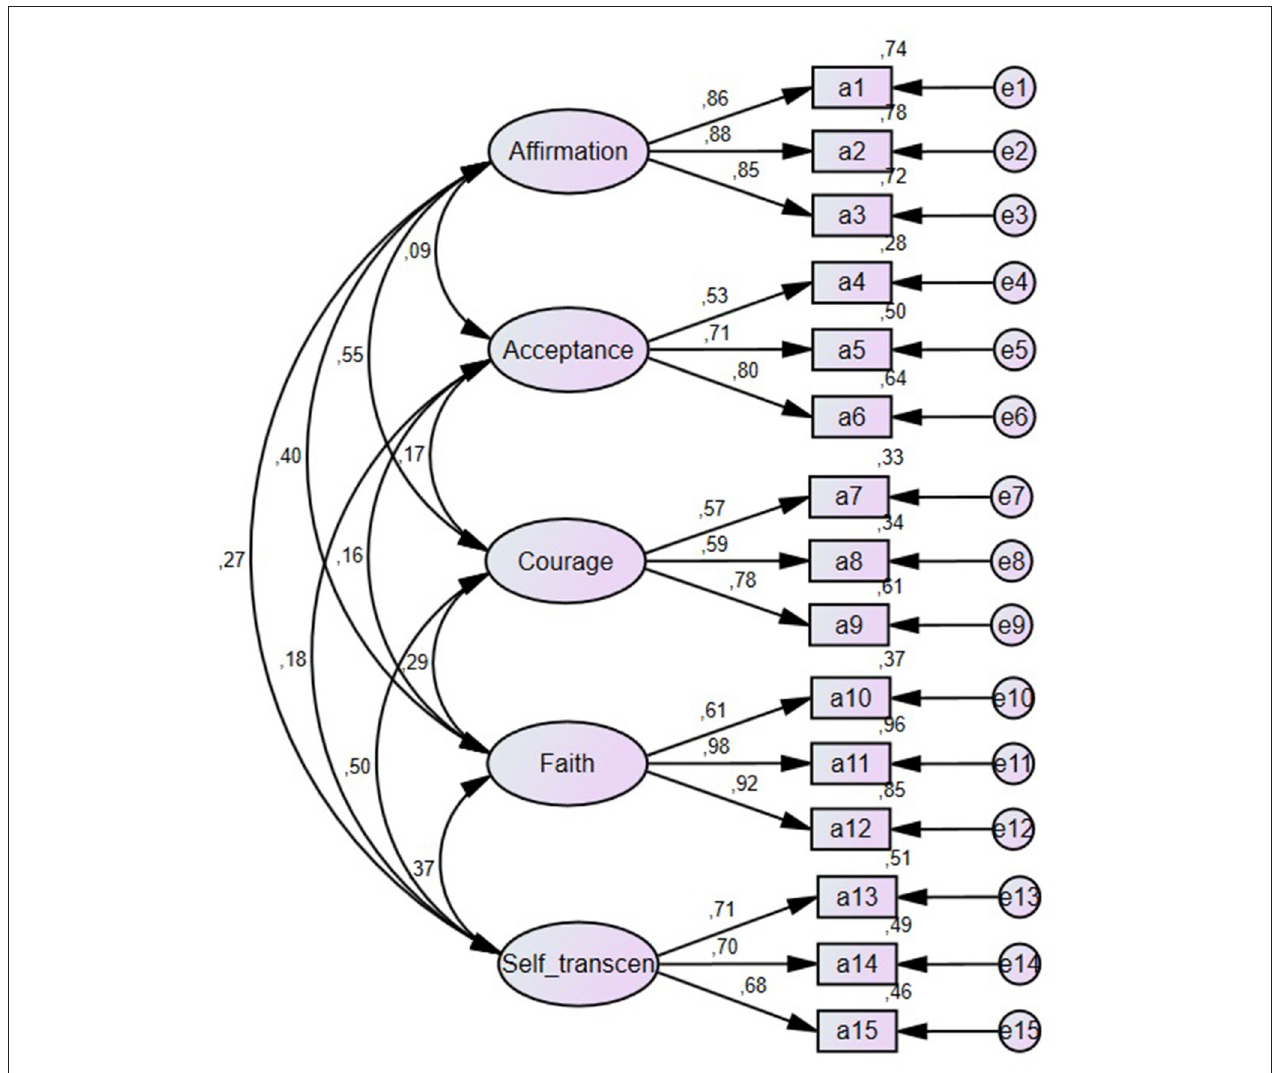
FIGURE 1 | Confirmatory factor analysis results indicating standardized regression